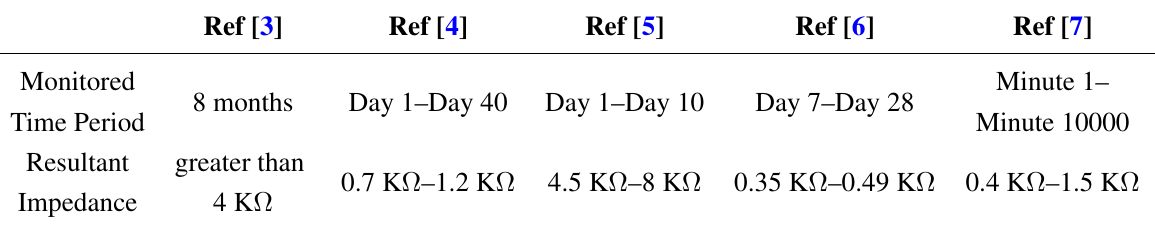
Table 1. Monitored cuff nerve-electrode interface impedance in prior